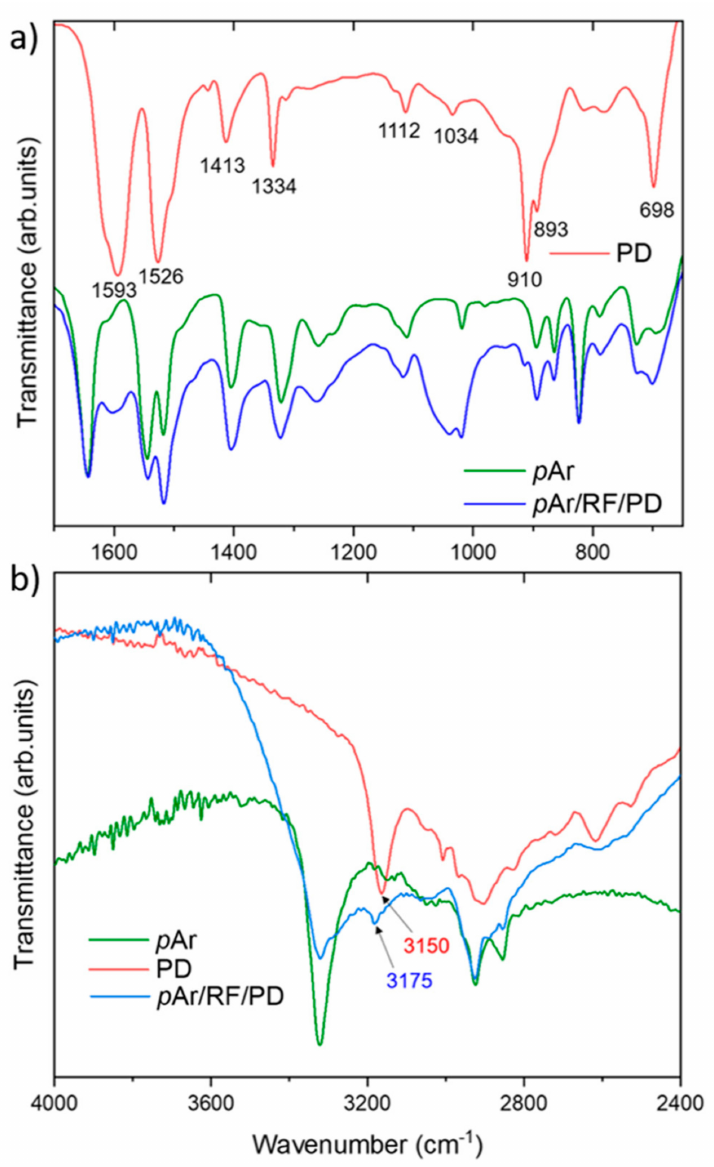
Figure 4. FTIR spectrum of polydopamine, reference, and RF plasma and polydopamine functional- ized para -aramid fabrics in the range of ( a ) 600–1750 cm − 1 and ( b ) 2400–4000 cm − 1